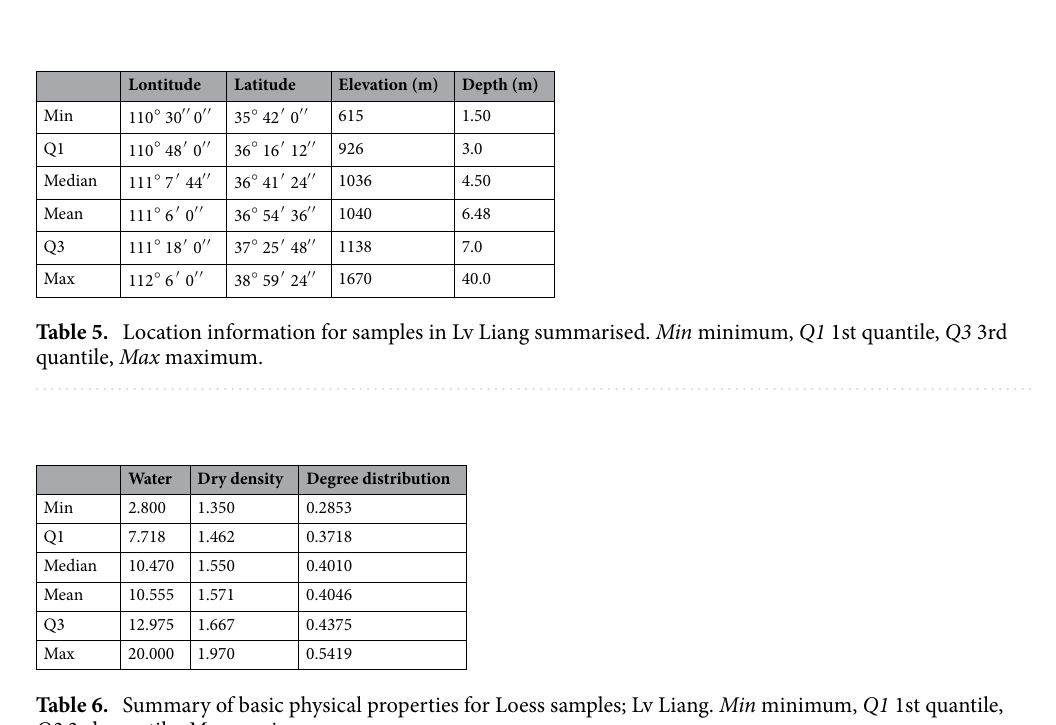
Figure 15. Demonstration of prepared sample and scanned outcome; ( a ) dried and tubed sample, ( b ) scanned sectional image.